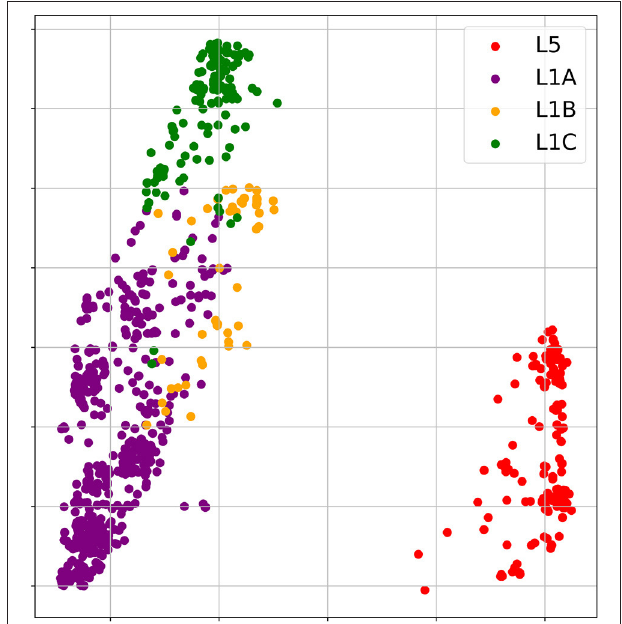
FIGURE 3 | Principal component analysis (PCA) visualizations of 1,000 amino acid scores of 1931 field PRRSV strains. [Red: L5 clade, purple: L1A clade, yellow: L1B clade & green: L1C